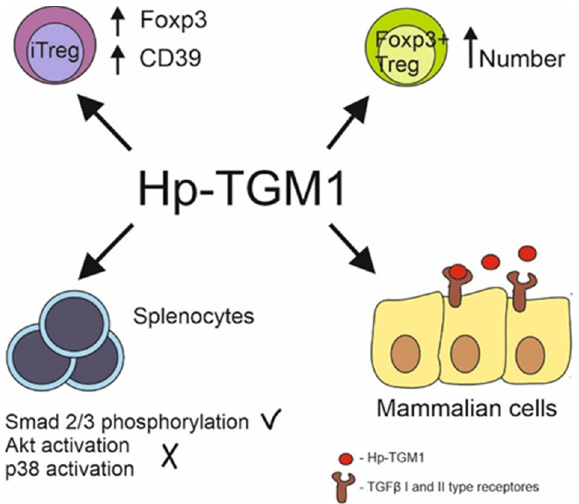
Figure 2. Hp-TGM1 functions similarly to mammalian TGF β despite lack of homologies between proteins. Hp-TGM1 binds to mammalian TGF β I and II type receptors; induces Smad 2/3 phosphorylation with lack in Akt and p38 signal pathway activation in murine splenocytes; induces generation of mice and human Foxp3 + Treg cells; increases Foxp3 and CD39 expression in induced Treg same as mammalian TGF β .